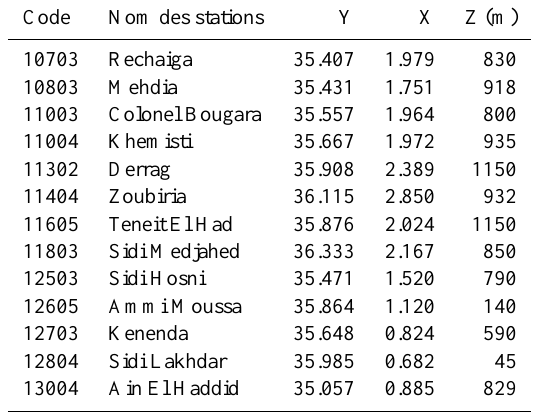
Tableau 1. Nom et coordonnées géographiques des stations pluvio- métriques (Degré